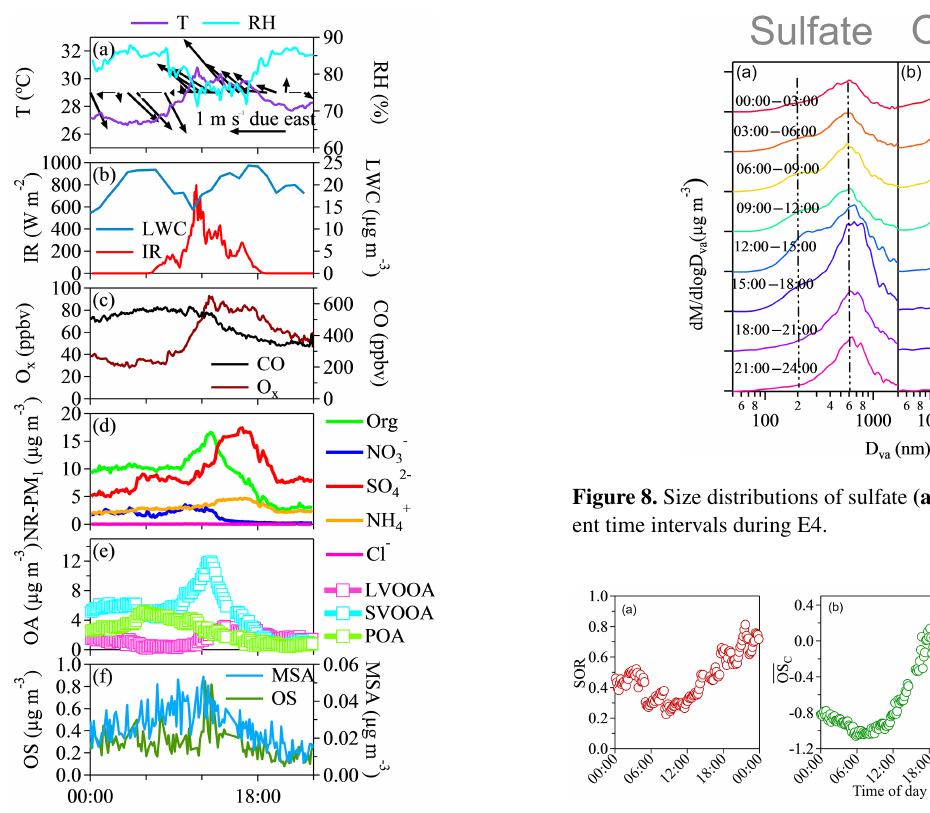
Figure 9. Oxidative evolution of aerosol components. (a) Sulfur oxidation ratio (SOR), (b) average carbon oxidation state OS c , and (c) benzene to toluene ratio ( B : benzene concentration at time t ; B 0 : benzene concentration at time 0; T : toluene concentration at time t ; T 0 : toluene concentration at time